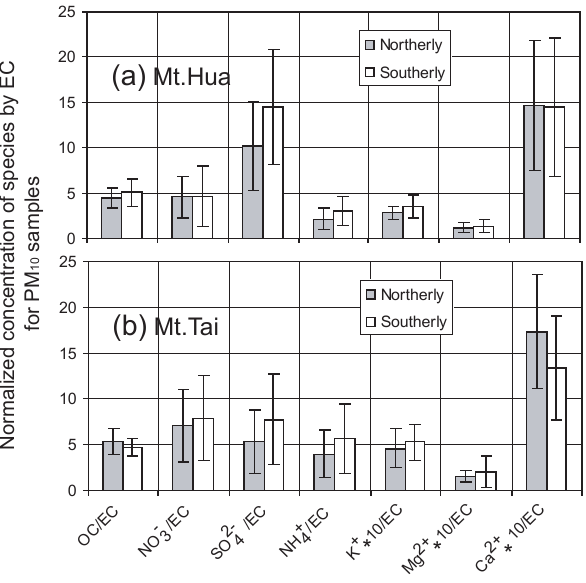
Fig. 8. Concentrations of species in PM 10 normalized by EC at